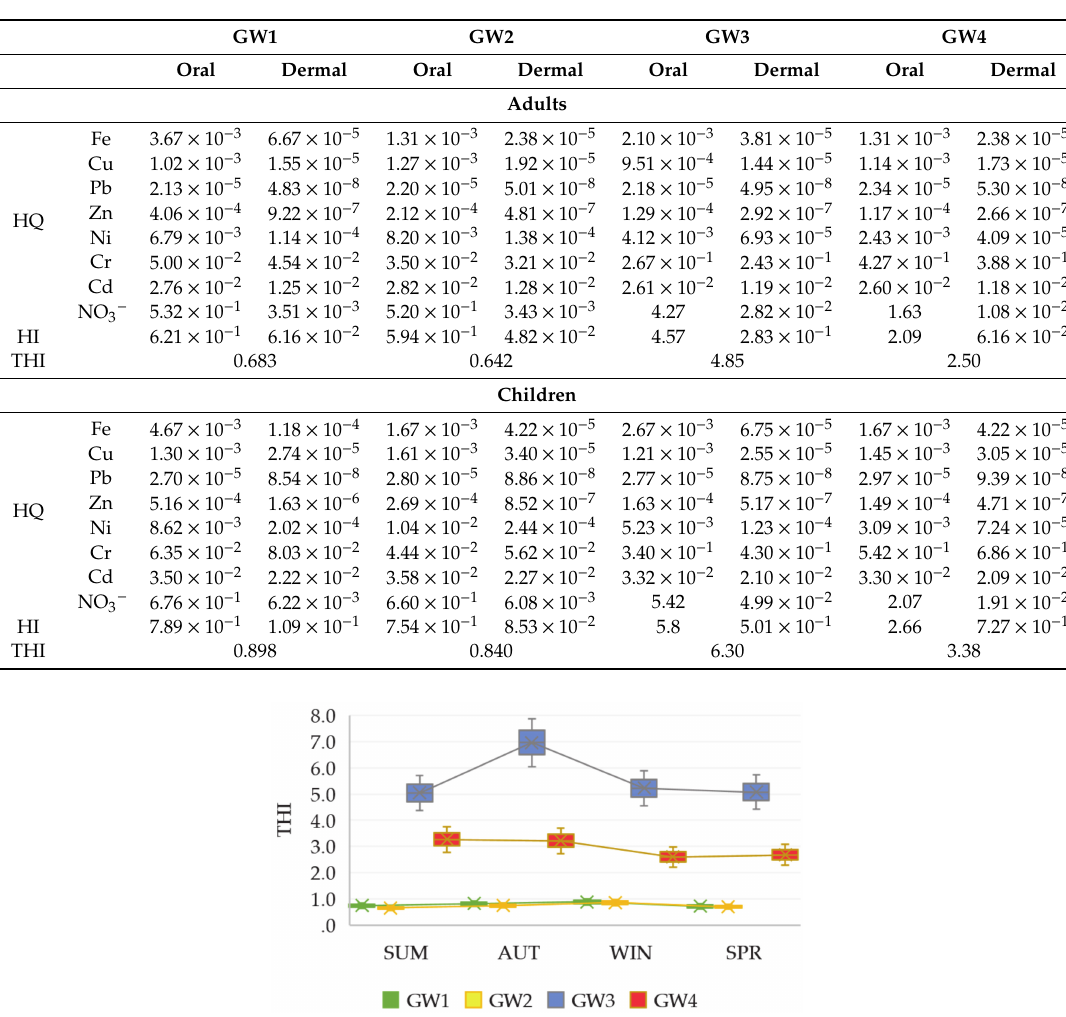
Table 7. Average hazard quotient (HQ), hazard index (HI), and total hazard index (THI) for adults and children.